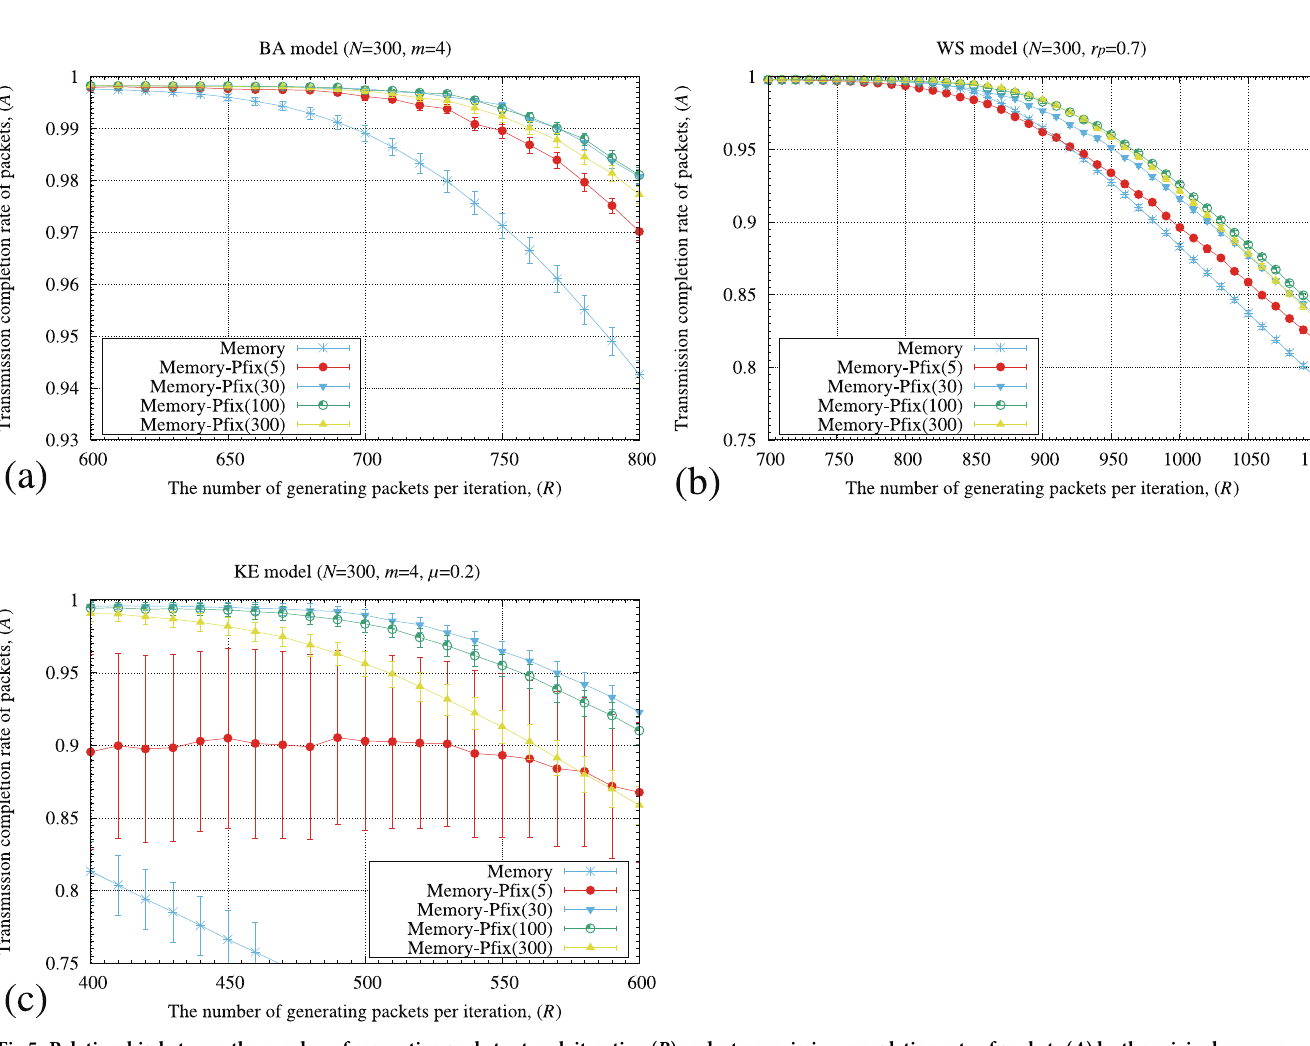
Fig 5. Relationship between the number of generating packets at each iteration ( R ) and a transmission completion rate of packets ( A ) by the original memory method and the memory-pfix method for the (a) BA, (b) WS, and (c) KE models. The numbers in the parentheses in the memory-pfix method indicate the periods of iterations for calculating the transmitting probability ( L ). In these figures, the standard deviation of each method is plotted as the error bars.